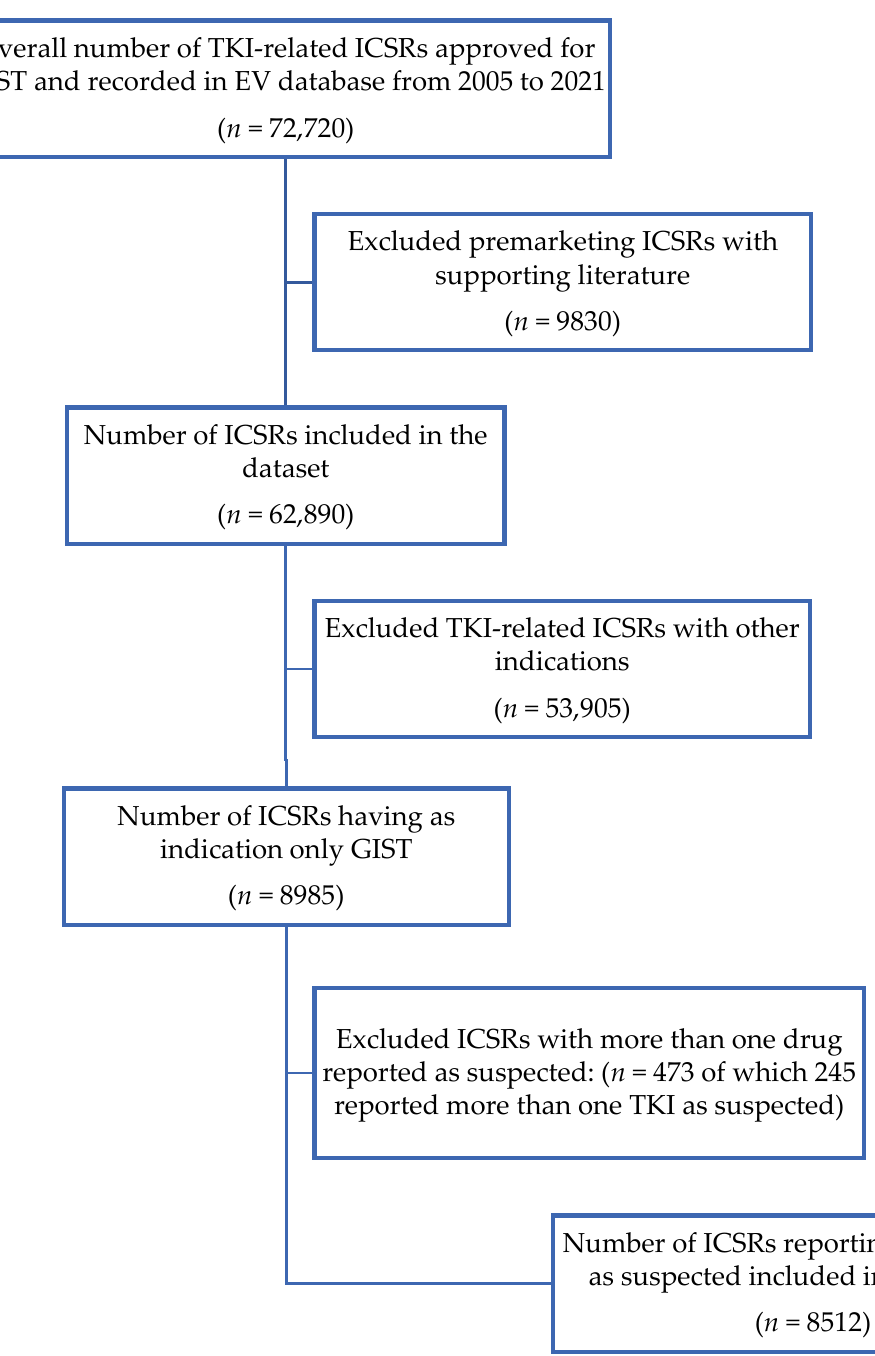
Figure 1. ICSR selection process. Abbreviations: EV = EudraVigilance; GIST = gastrointestinal stromal tumor; ICSRs = individual case safety reports; TKI = tyrosine kinase inhibitors.